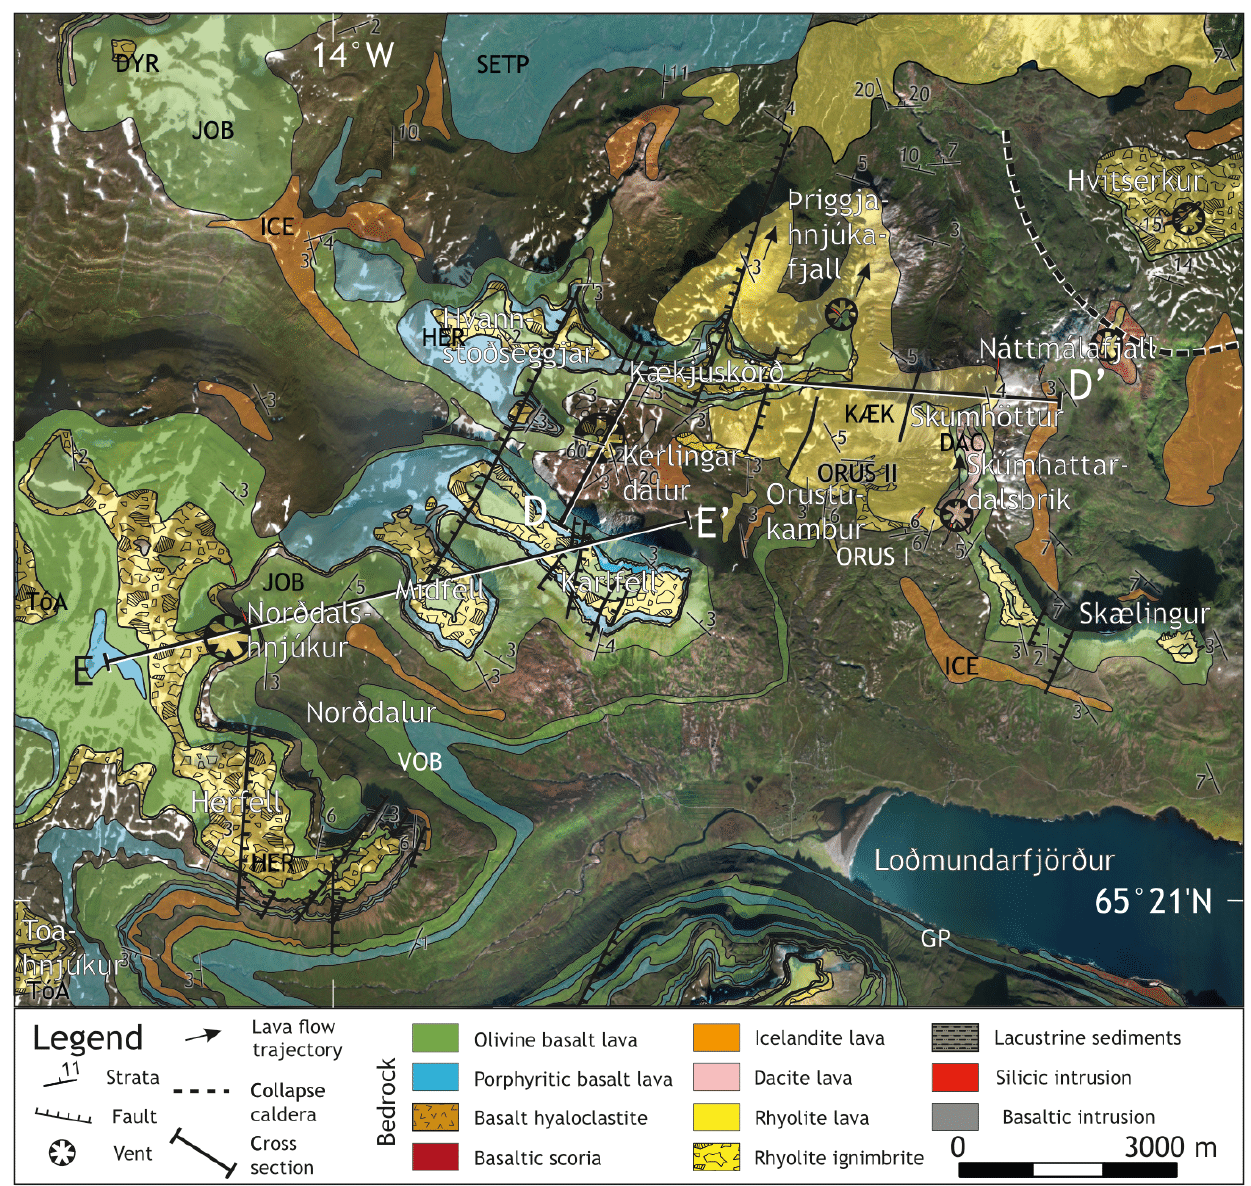
Figure 9: Geological map of the area west and north of Loðmundarfjörður. For location, see Figure 3. Satellite image from 2009 accessed through Bing Maps ( https://www.bing.com/maps ). For the cross sections D–D (cid:48) and E–E (cid:48) , see Figure 13. For names of stratigraphic formations, see text and Figure